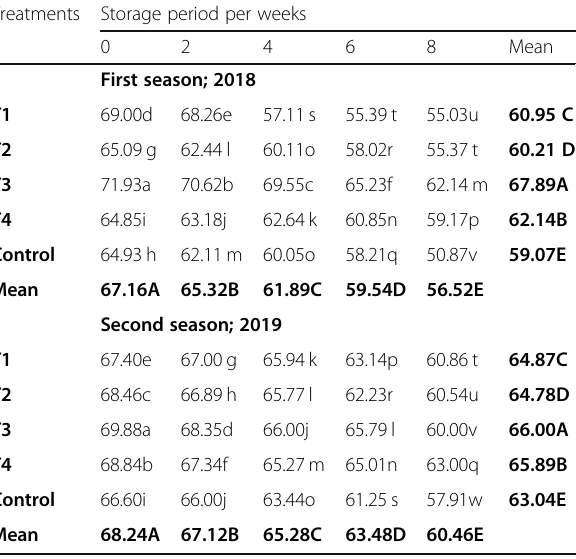
Table 8 Effect of preharvest spraying with moringa leaf extract, boric acid, and chelated calcium on total phenolic content of Hollywood plum fruits stored at 0 ± 1 °C and RH 85 – 90% during